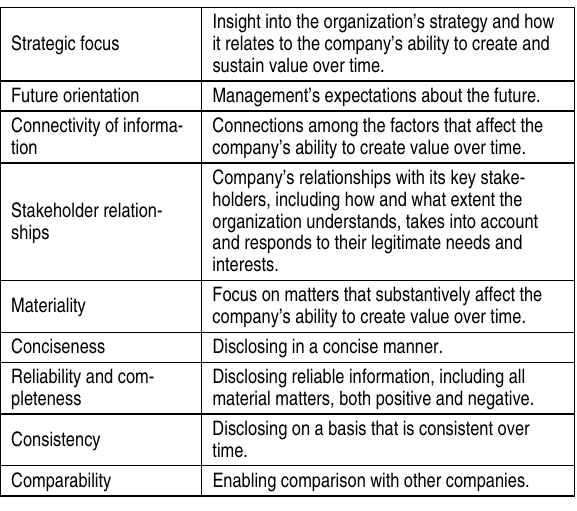
Table 1. The Framework guiding